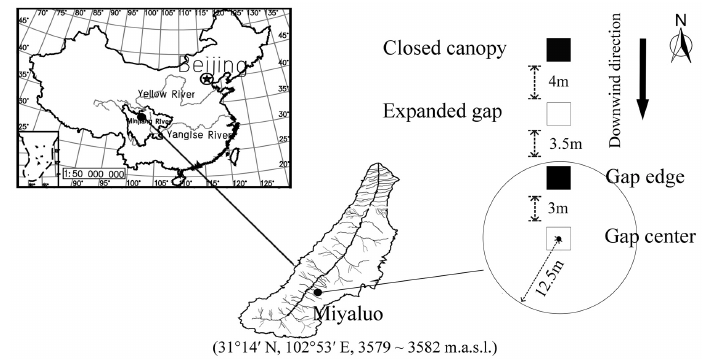
Figure 1. Study region in the eastern Tibet Plateau and the experimental layout showing the litter bag distribution in the selected gaps. The circles (the diameter of the circle is 25 m) and squares (4 × 4 m) show an example of one possible spatial arrangement between the forest gap and litter bag positions. The positions are spaced at a distance of 3 to 4 m to ensure a gradient of snow cover depth and light intensity during decomposition. To quantify the cellulose and lignin concentrations in the litter at different critical periods, which were identified based on Olsson’s period division of the cold season [35] and the field investigation of our previous